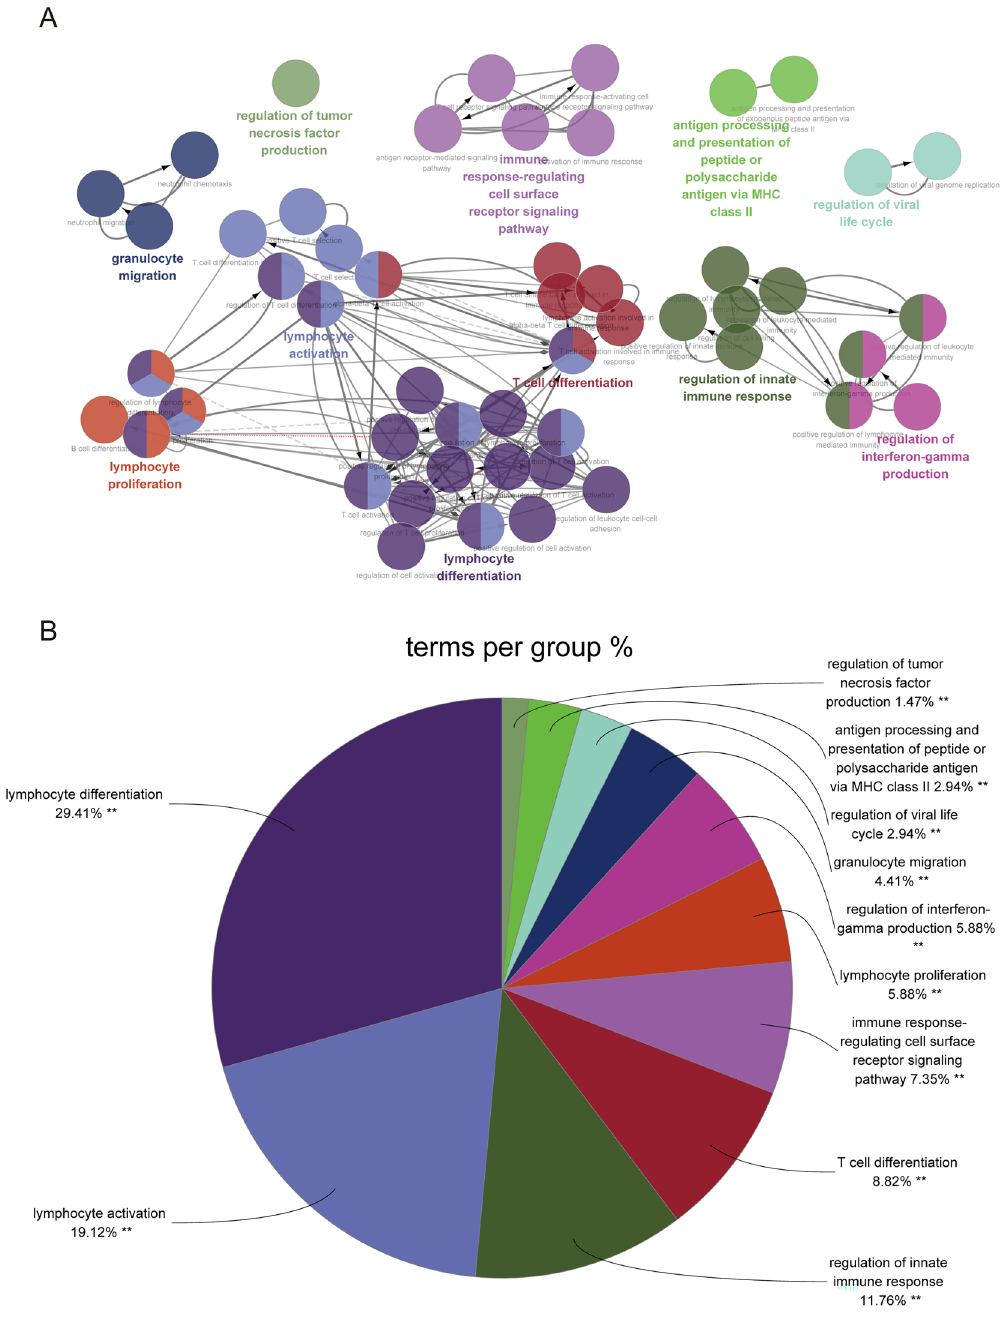
Figure 5. Enrichment analysis of DEGs biological processes (BPs) in GSE142255 was performed using ClueGO. Then, ( A ) a BPs network was constructed. ( B ) The proportion of relevant genes in major BPs are presented in pie